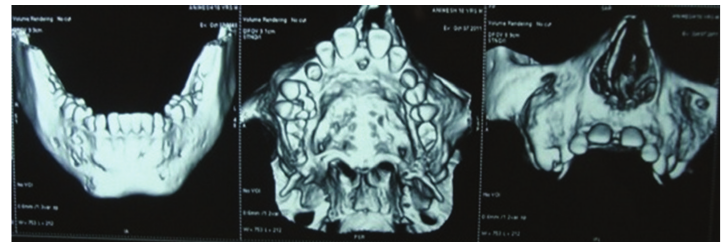
Figure 8: CT scan showing 3D reconstruction (Case 1).